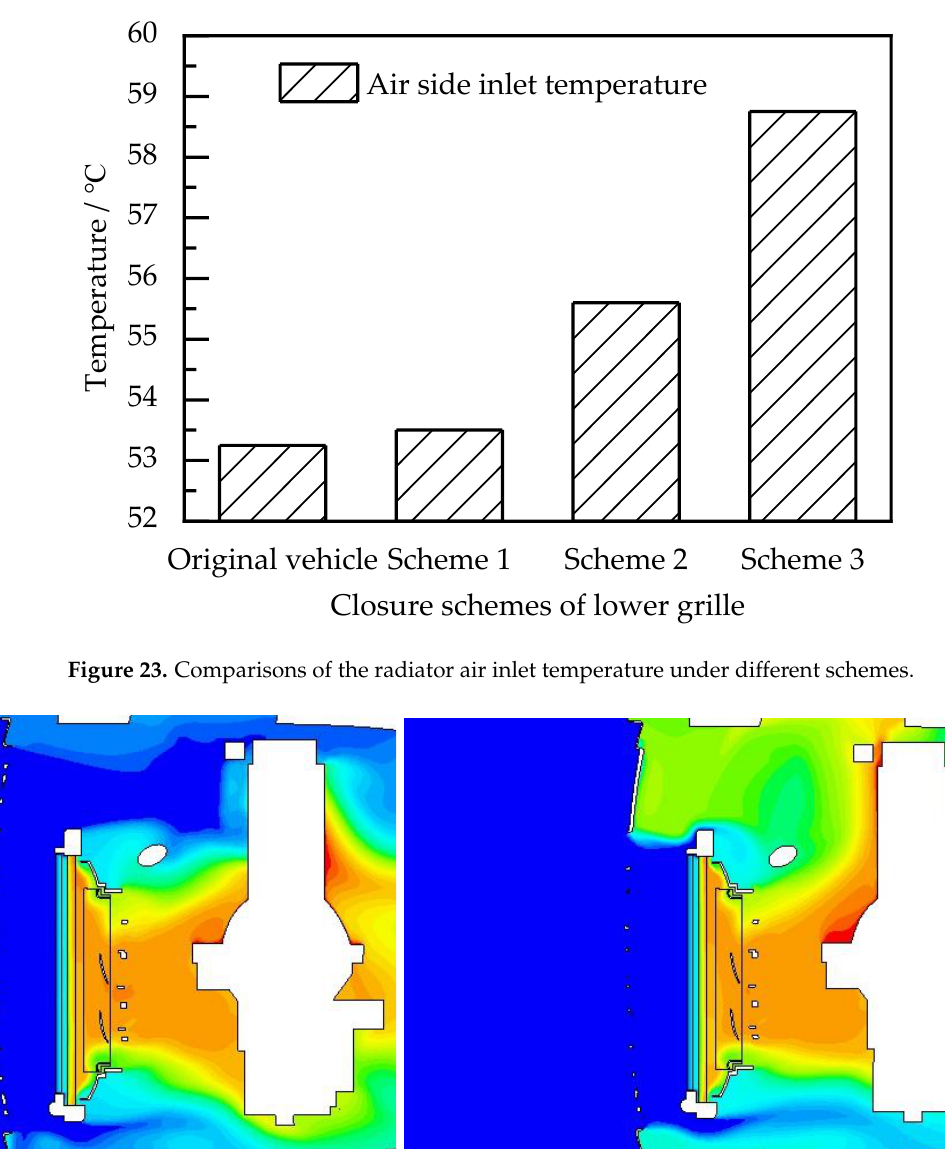
Figure 22. Velocity fields of z = 0.08 m section under different lower grille closure schemes: ( a ) original vehicle; ( b ) scheme 1; ( c ) scheme 2; ( d ) scheme 3. Figure 23 reflects the inlet temperature of the radiator under different lower grille